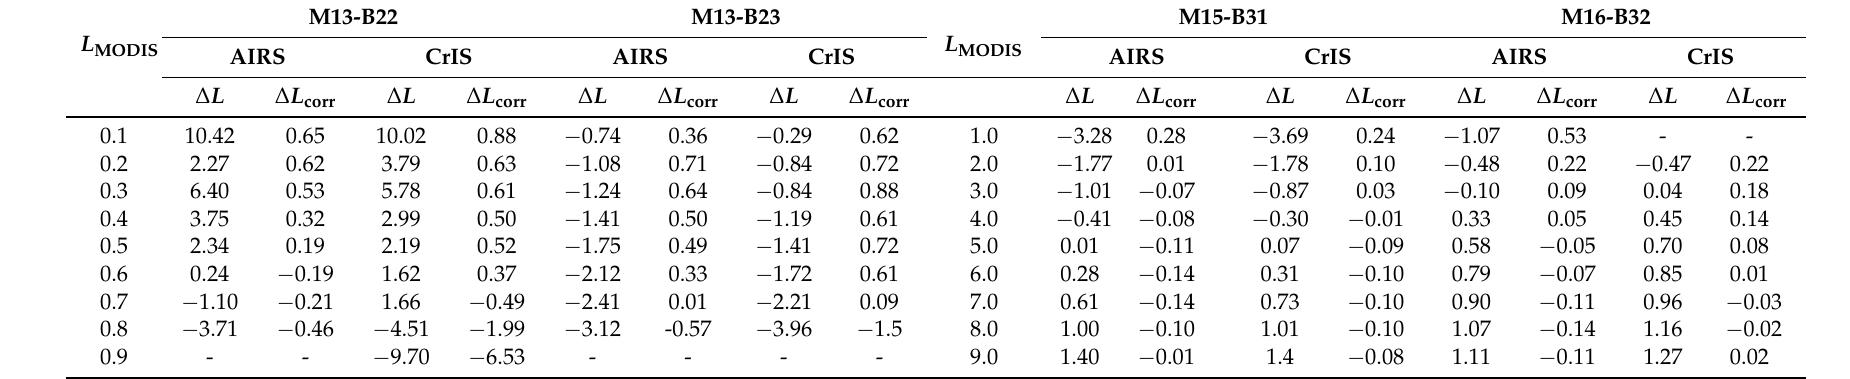
Table 4. Percent difference in radiance without/with RSR correction ( L MODIS unit: W/m 2 / µ m/ sr; ∆ unit: